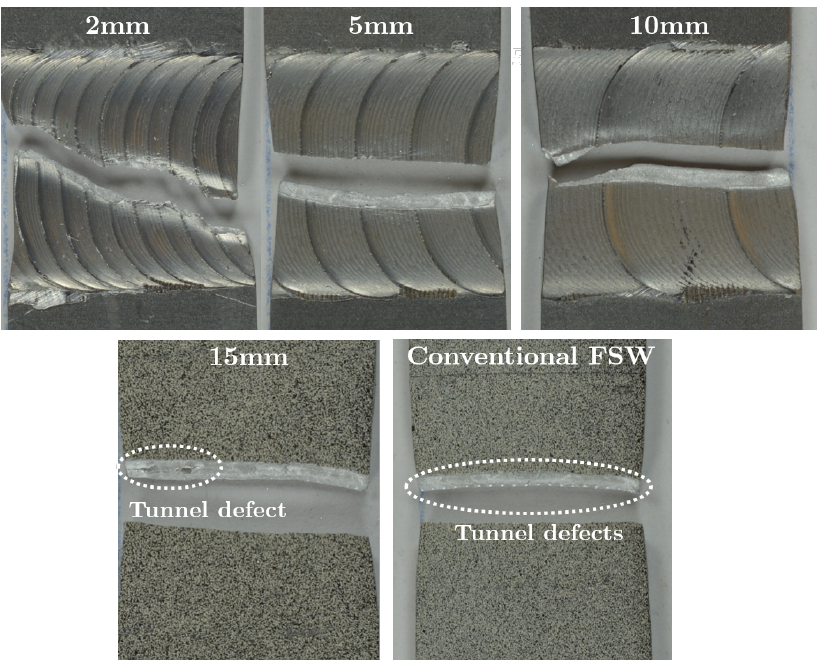
Figure 6. Fracture analysis of all stitch-welded specimen and the conventional FSW